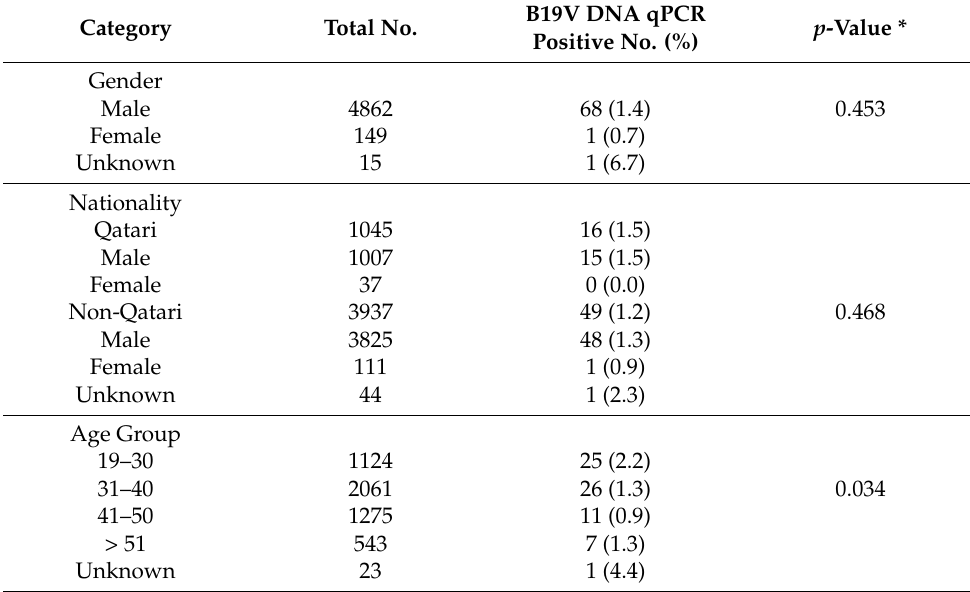
Table 3. B19V viremia in the studied population ( n = 5026).